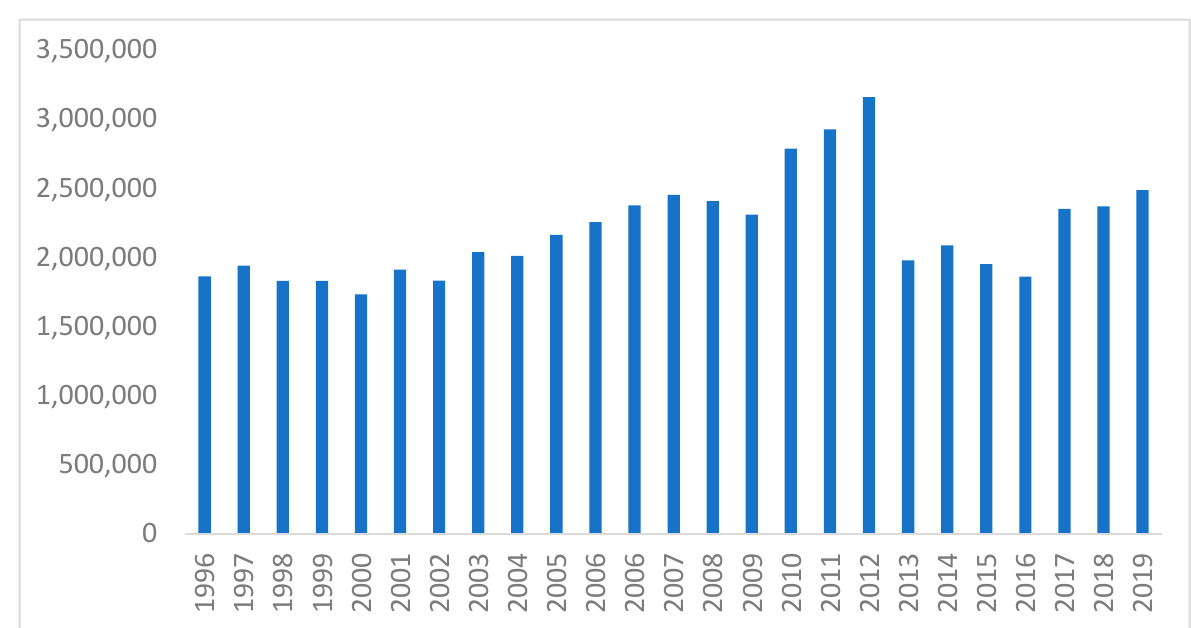
Figure 1. The number of the annual Hajj pilgrims per year 1996–2019.